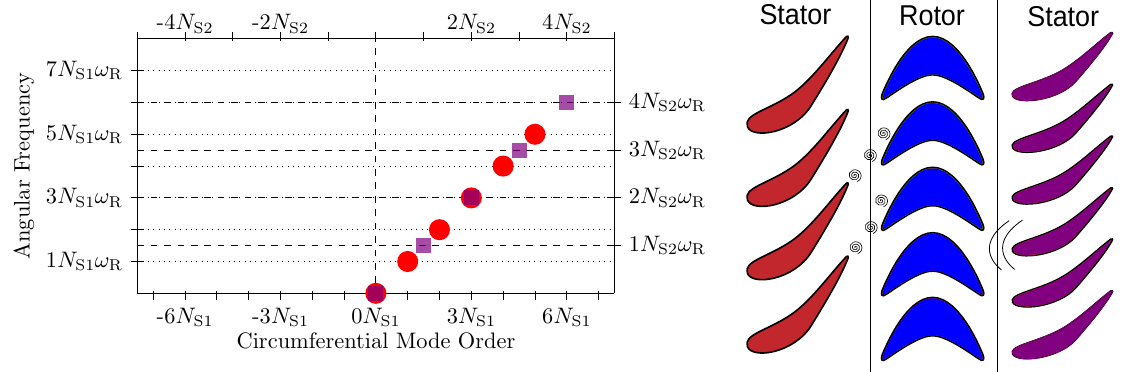
Figure 1. Red and violet harmonic sets represent the unsteady disturbances caused by two neighbouring blade rows with equal rotational speeds, e.g., wakes and potential effects in a rotor system due to neighbouring stators whose vane count ratio is